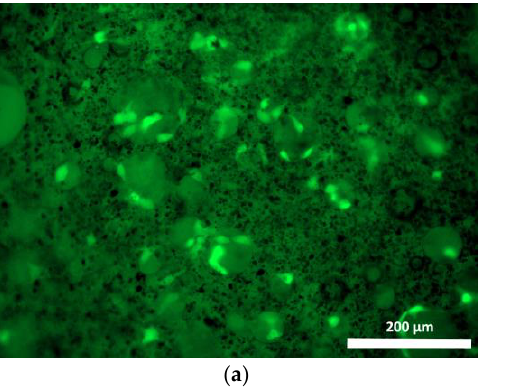
Figure 8. Viable fibroblasts on the surface of Composition 2 specimen (staining fluorochrome — Calcein AM (BD Pharmingen ™ ): ( a ) 24 h cultivation; ( b ) 72 h cultivation. Mag. 100×.